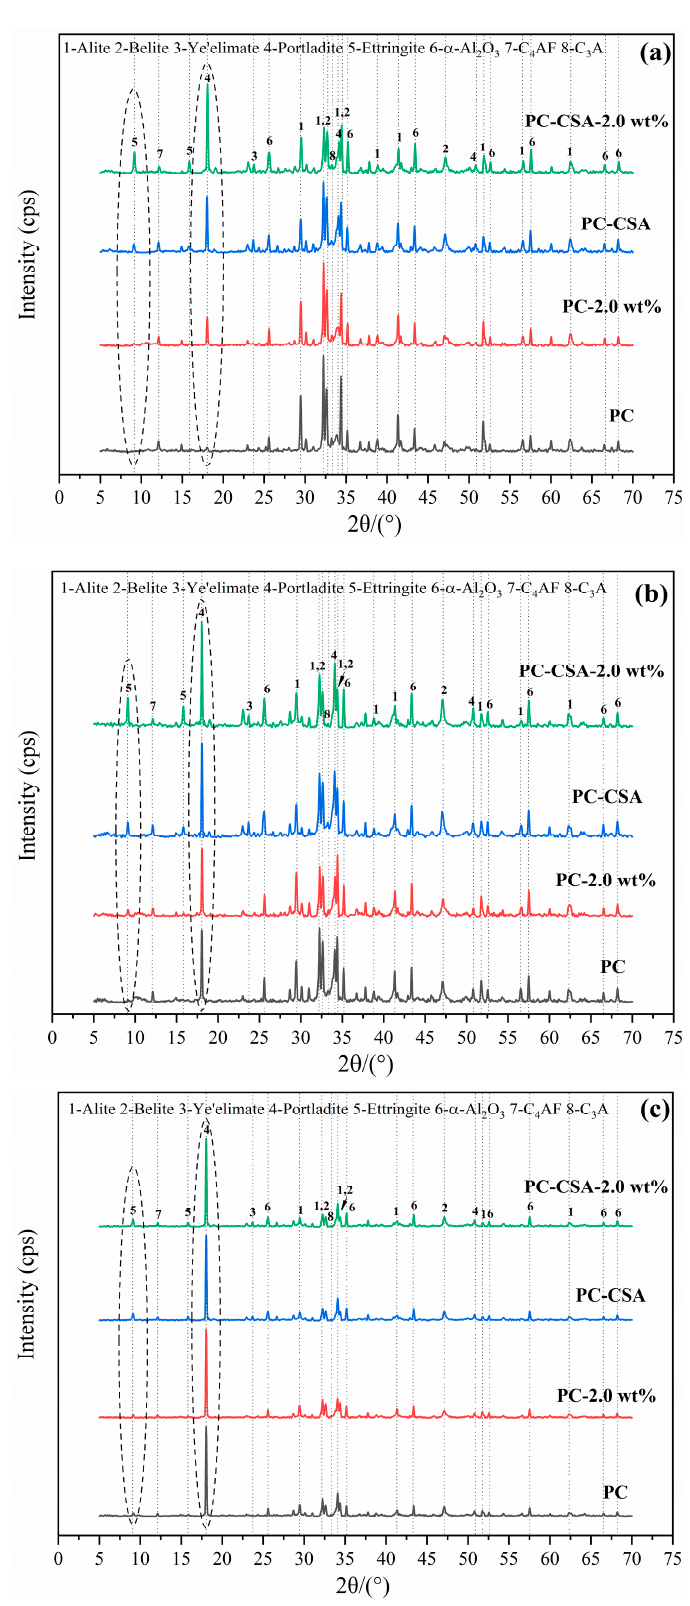
Figure 8. XRD patterns of different binders at different curing times: ( a ) 10 h; ( b ) 1 d; ( c ) 3 d.